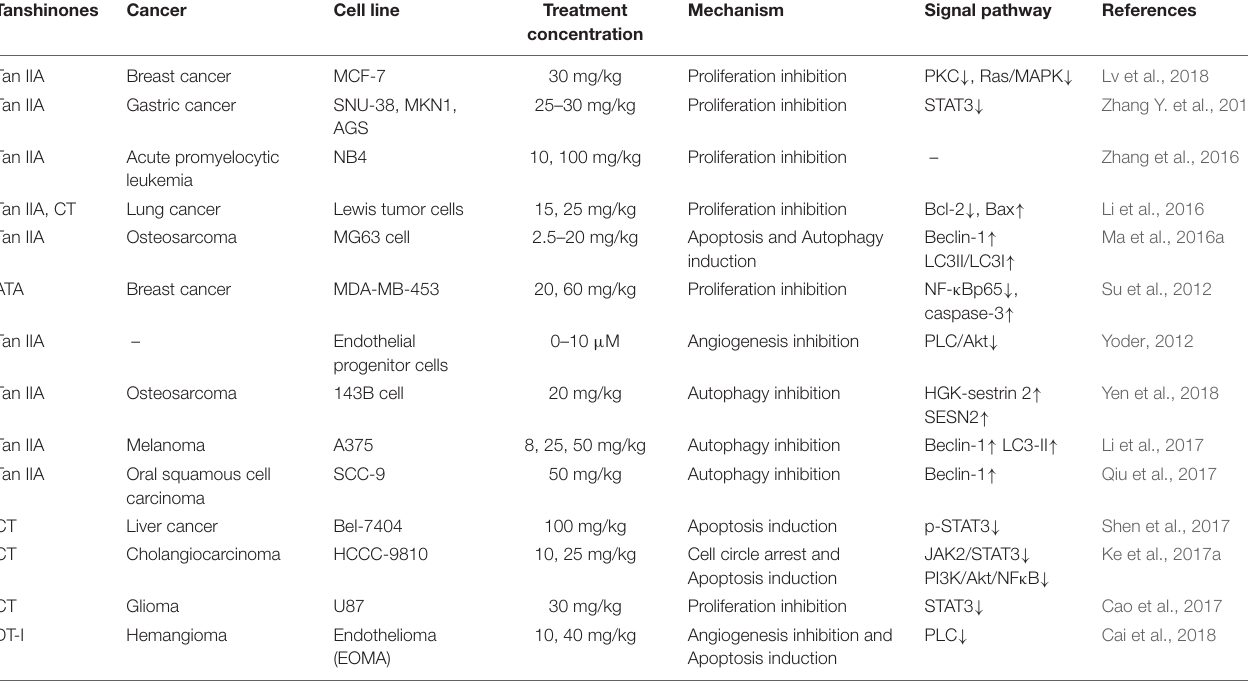
TABLE 2 | The antitumor experiment of tanshinone compounds in vivo